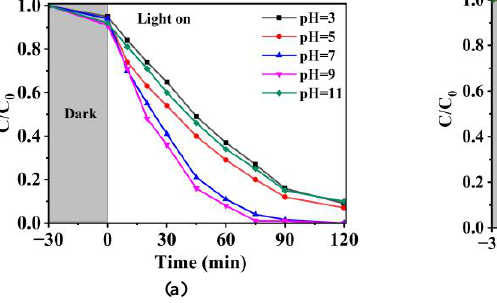
Figure 3. Effects of pH on the degradation efficiency of ( a ) NOR, ( b ) SMX and ( c ) TCH by Ag/CNQDs/g-C 3 N 4 (25 °C, photocatalyst dosage = 0.2 g/L, antibiotic concentration = 10